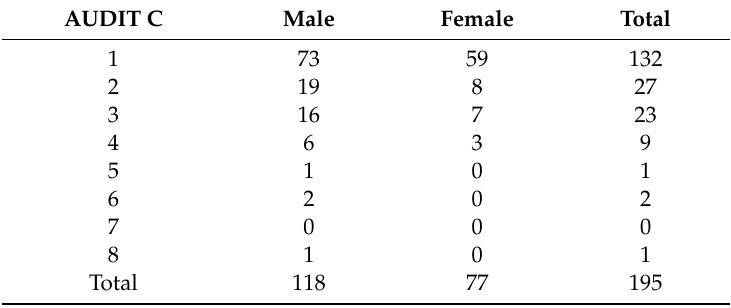
Table 5. Number of students who consumed alcohol by Alcohol Use Disorders Identification Test–Concise (AUDIT-C) score and